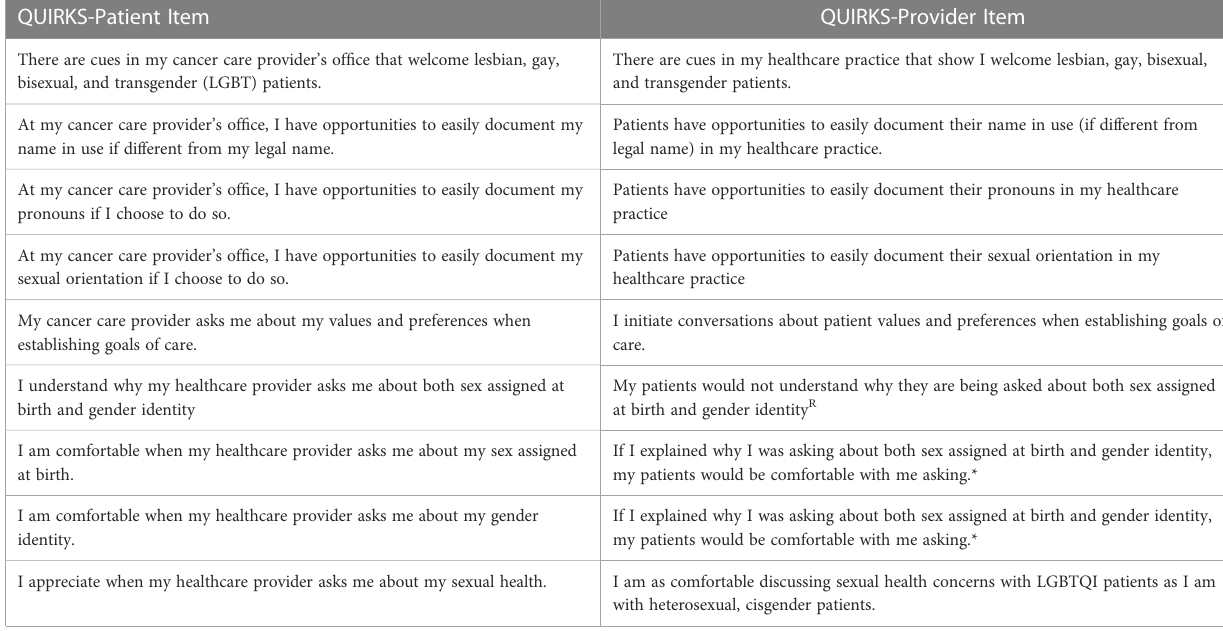
TABLE 1 Similar items assessed on QUIRKS-Patient and QUIRKS-Provider